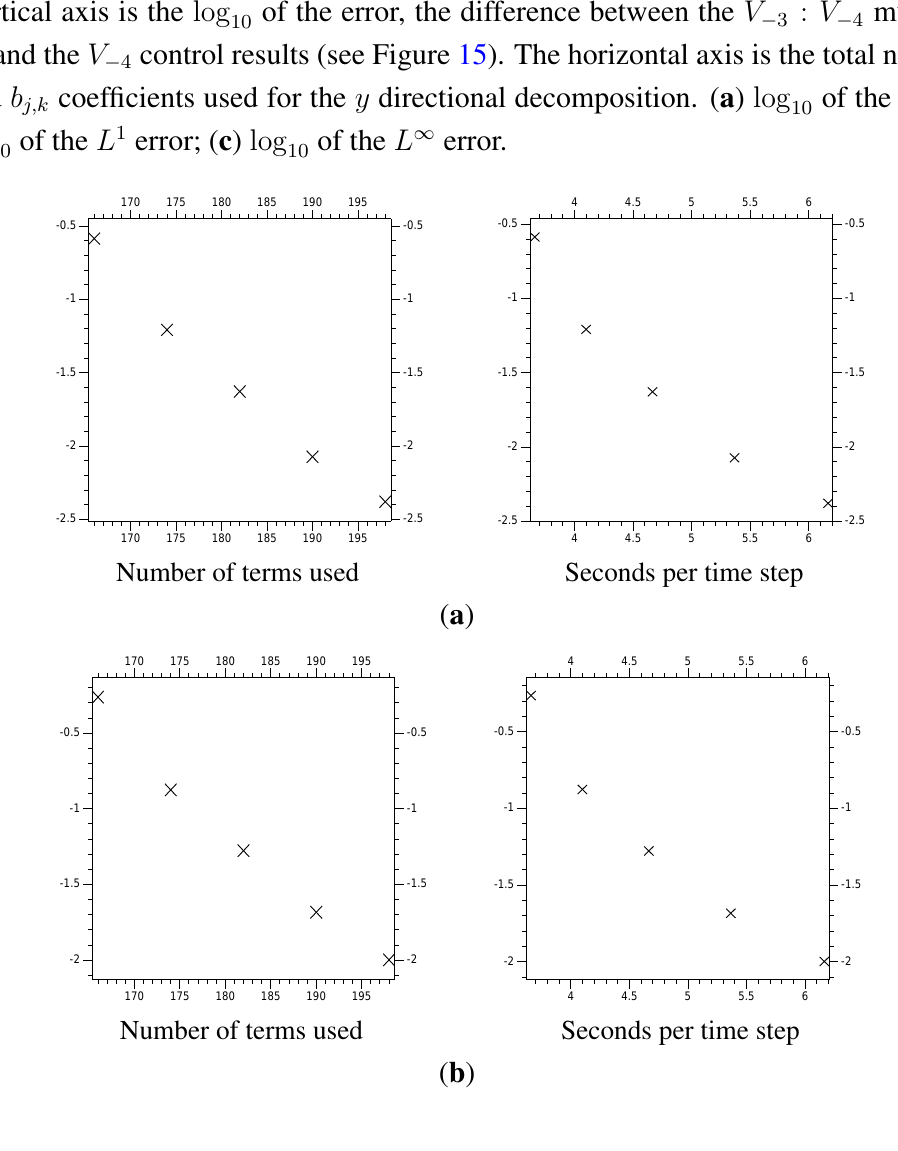
: V − multi-scale 3 4 of the L 2 error; 10